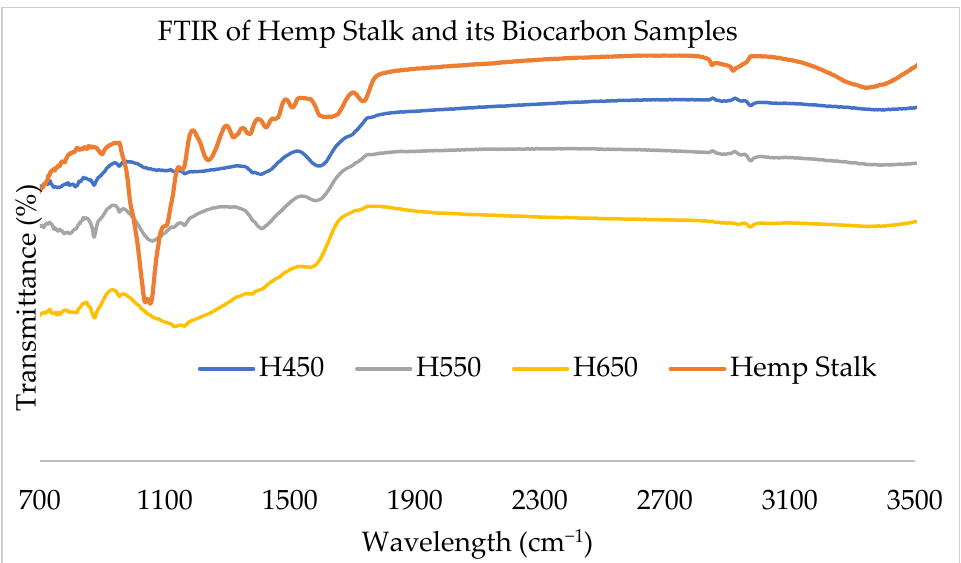
Figure 2. FTIR of the hemp stalk and its biocarbon at different pyrolysis temperatures.